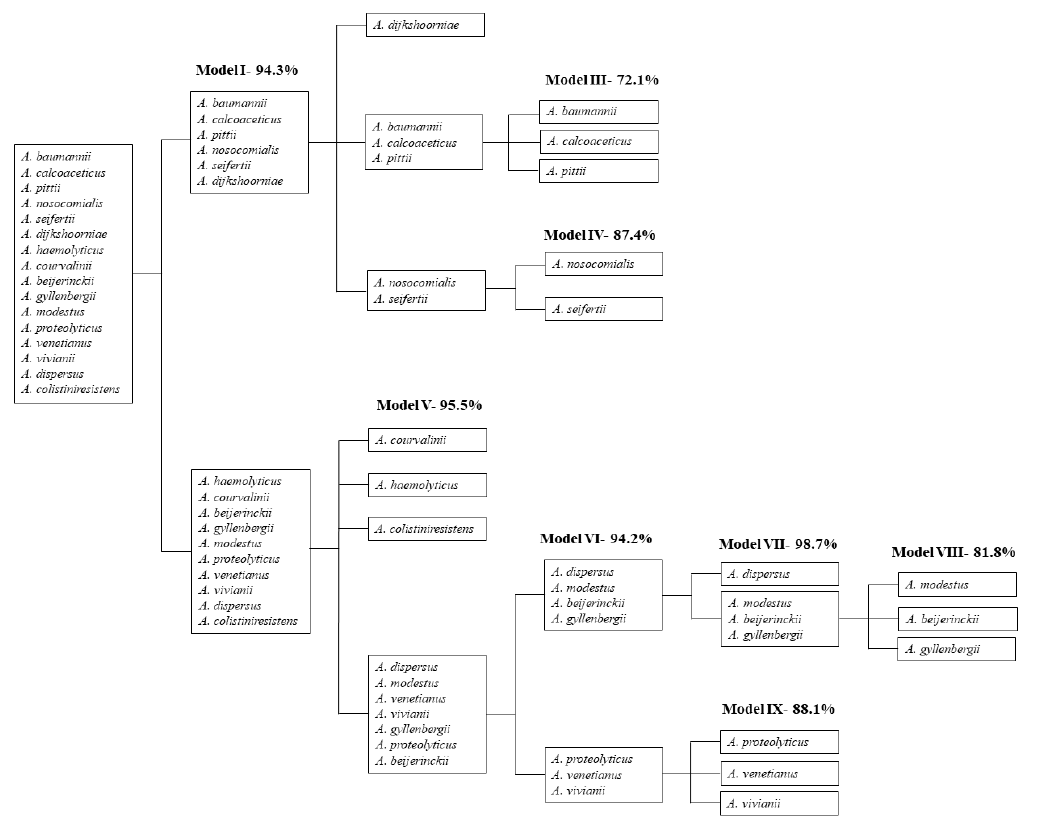
Figure 3. Flowchart developed for the identification of Acinetobacter species, including the number of developed partial least squares discriminant analysis (PLSDA) models and percentage of correct species assignments of each model.